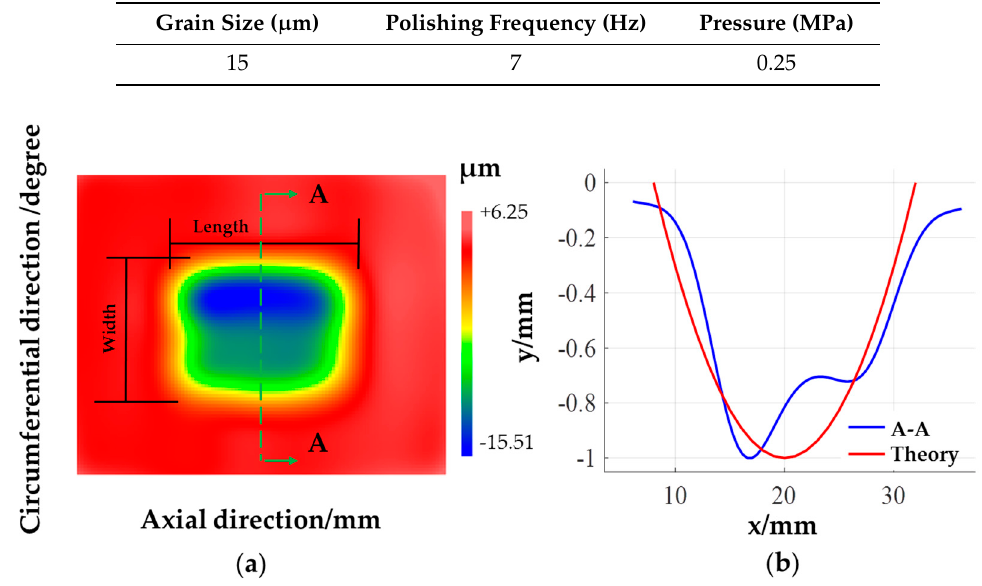
Table 2. The optimal experimental parameters for removal function.